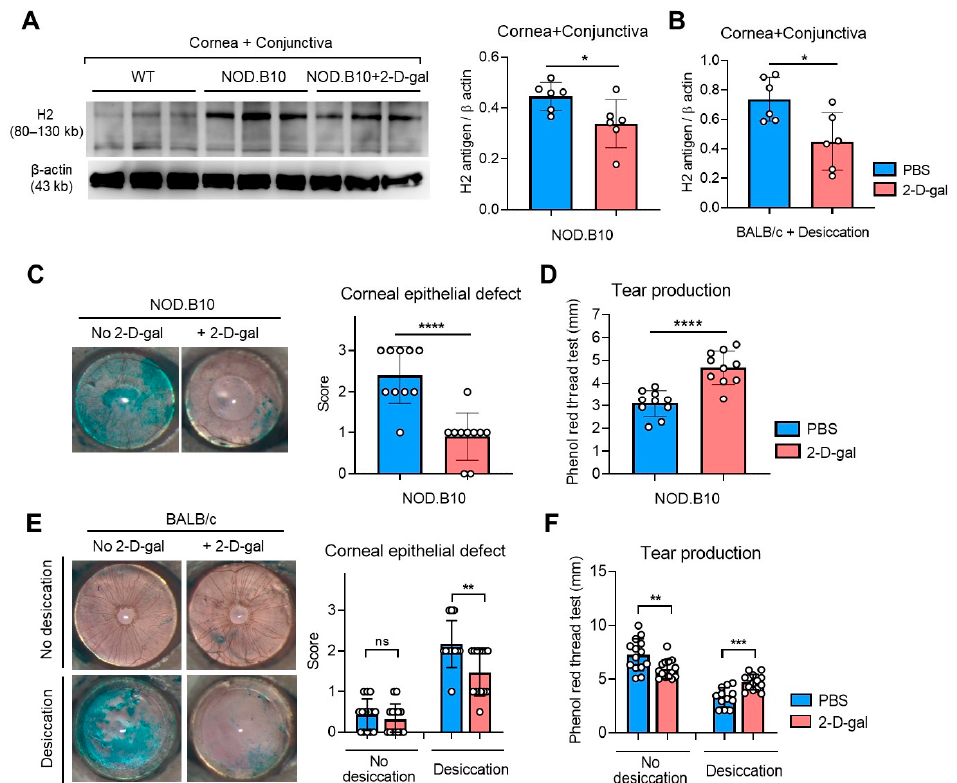
Figure 2. Therapeutic effects of α (1,2)-fucosylation blockade by 2-D-gal on clinical signs of DED in two mouse models. ( A ) Western blot images and densitometric analysis of H2 antigen relative to β actin in the cornea and conjunctiva in wild-type (WT) C57BL/6 mice and NOD.B10.H2 b (NOD.B10) mice with or without 2-D-gal treatment. ( B ) Densitometric results of Western blot analysis for H2 antigen relative to β actin in the cornea and conjunctiva in BALB/c mice under desiccating stress with or without 2-D-gal treatment. ( C ) Representative corneal photographs after Lissamine Green vital dye staining in NOD.B10 mice with or without 2-D-gal treatment. Quantification of corneal epithelial defects as graded by the standardized 4-point scoring system (0–3). ( D ) Tear production measurement by using a phenol red thread test in NOD.B10 mice with or without 2-D-gal treatment. ( E ) Representative corneal photographs and quantification of corneal epithelial defects in BALB/c mice under physiological (no desiccation) or desiccating stress condition with or without 2-D-gal treatment. ( F ) Assay for tear production by a phenol red thread test in BALB/c mice (under physiological or desiccating condition) with or without 2-D-gal treatment. A circle depicts data (mean ± SD) from an individual animal. * p < 0.05, ** p < 0.01, *** p < 0.001, **** p < 0.0001, ns: not significant.